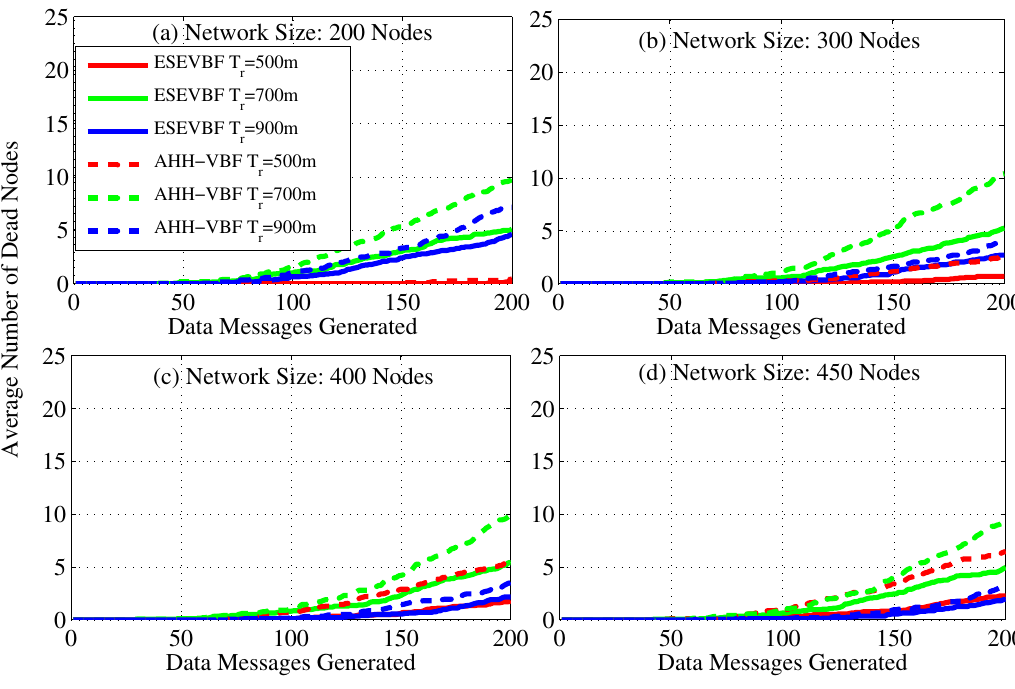
Figure 14. Number of dead nodes for varying number of data packets generated by the source nodes in the